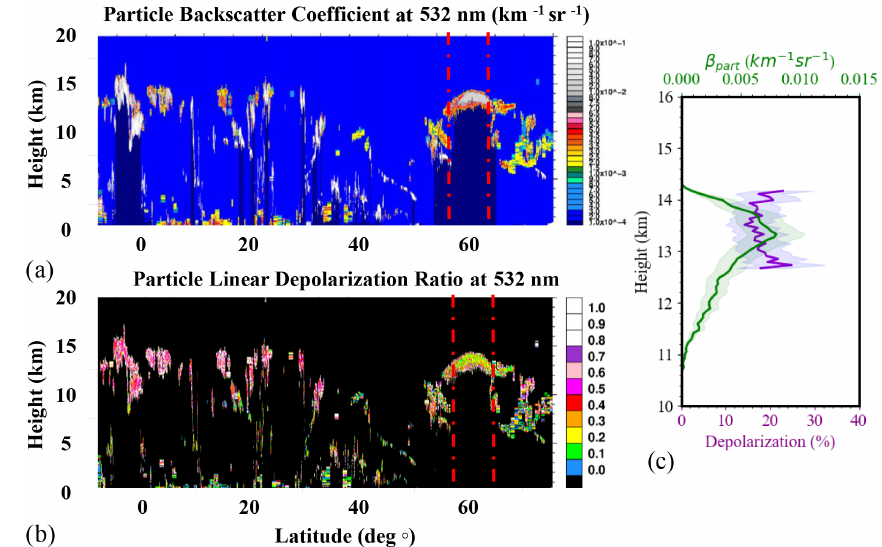
Figure 6. Same as Fig. 5 but for the daytime overpass of CALIPSO on 15 August 2017, 18:22–18:35UTC, shown in Fig. 4b. (a) The smoke plume is now above the local tropopause at approximately 14km, between 60 ◦ and 75 ◦ latitude. Dashed red lines denote the spatial averaging applied for the retrieval of optical properties shown in the right plot. (b) PLDR values at 532nm ( c , purple line) exceed 17% at the height of the plume. (Note that the altitude range for this plot is from 10 to 16km, whereas in Fig. 5b it is from 0 to